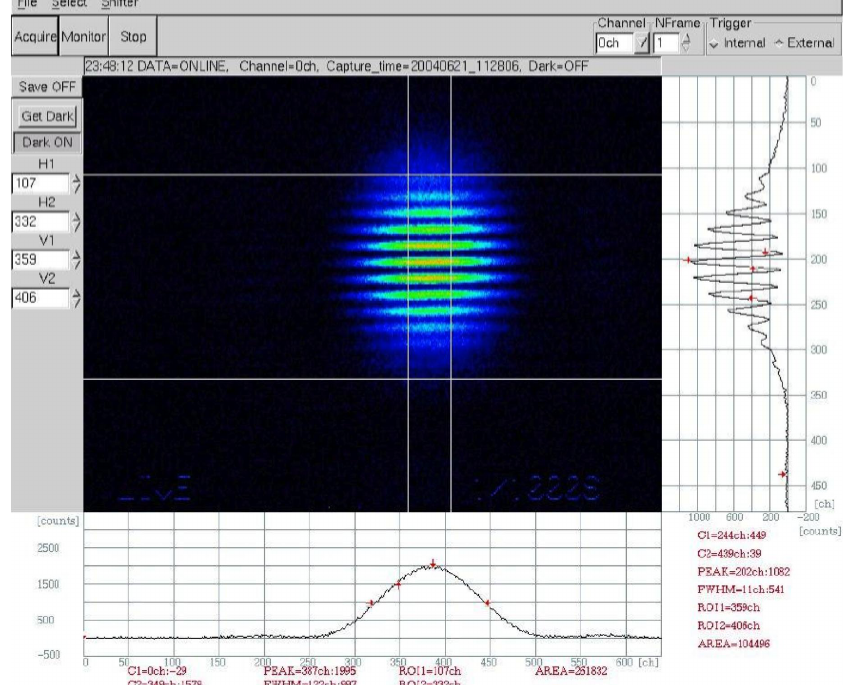
FIG. 5. (Color) Example of an interferogram.